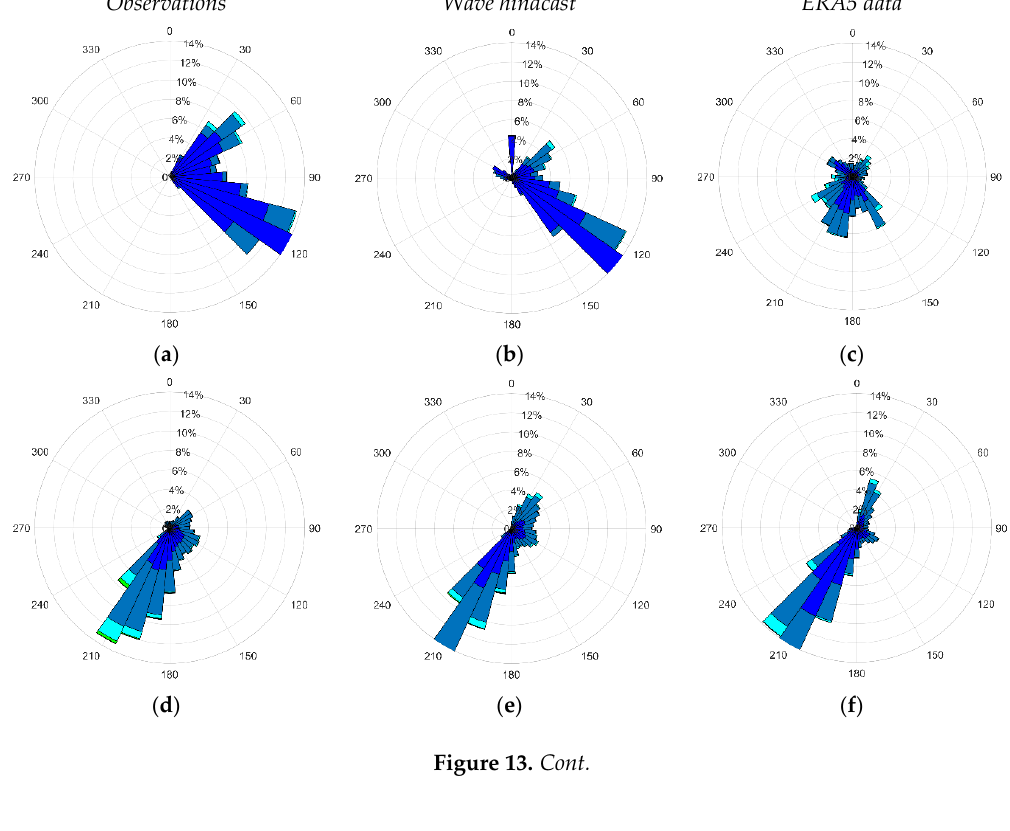
) symbols refer to (cid:35)